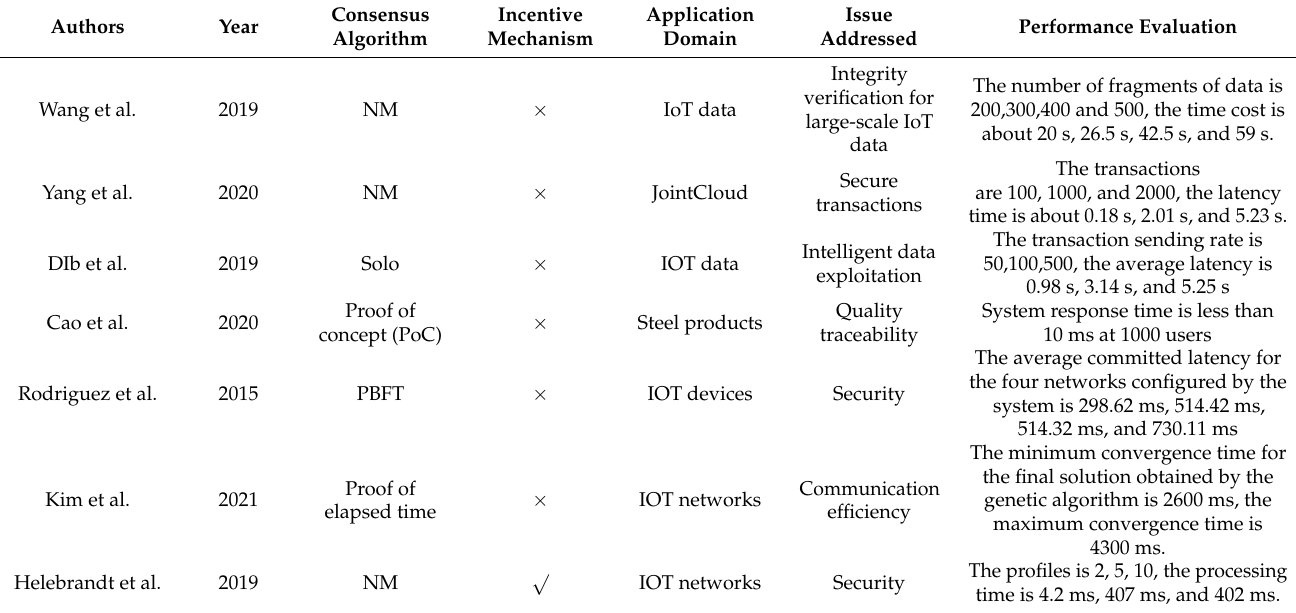
Table 1. Differences between IoT security solutions (NS: mention but not specify, NM: not mentioned).